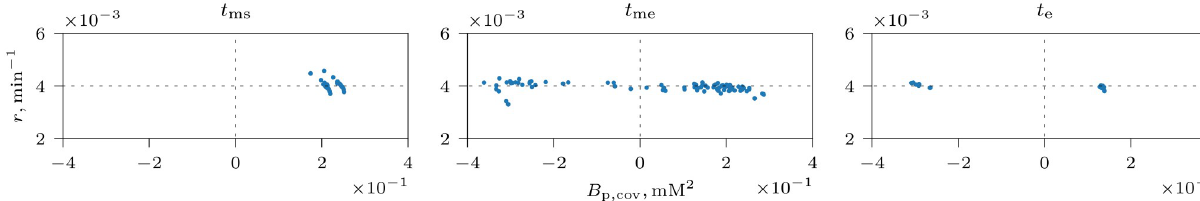
Fig 5. Evolution of a dimorphic population. Each dot represents the reproduction rate r of a tracked cell averaged over an environmental cycle plotted against its phenotypic balancedness B p,cov . Data are shown for three time points during a simulation in a chemostat with a variable OFF phase, T ¼ 100 min , T on = 1 min, T off ¼ 99 min , CV( T off ) = 5 %, and D = 4 × 10 − 3 min − 1 . The initial balanced population (left, time t ms ) accumulates variation created by mutation (middle, time t me ). At the end of the simulation ( t e ), subpopulations of BCs and ICs coexist at a stable equilibrium frequency. S4 Video shows the dynamics of this plot during the whole length of the simulation.